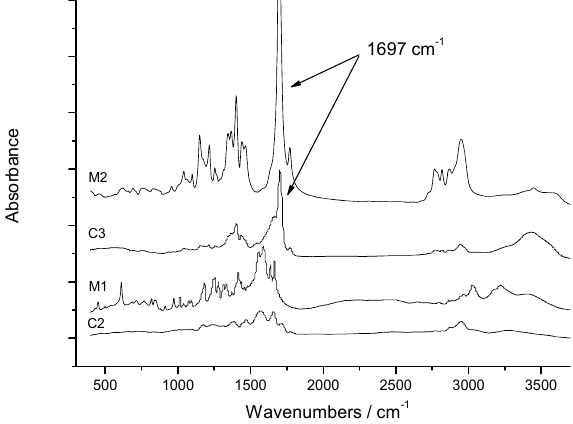
Figure 3. IR spectra of amidoacidified C2, thermally imidized C3, and model compounds M1 and M2 (3-( N , N -dimethylamino)propyl maleamic acid and 3-( N , N -dimethylaminopropyl)maleimide). The characteristic absorption band of cyclic imides in C3 and M2 at 1697 cm − 1 are